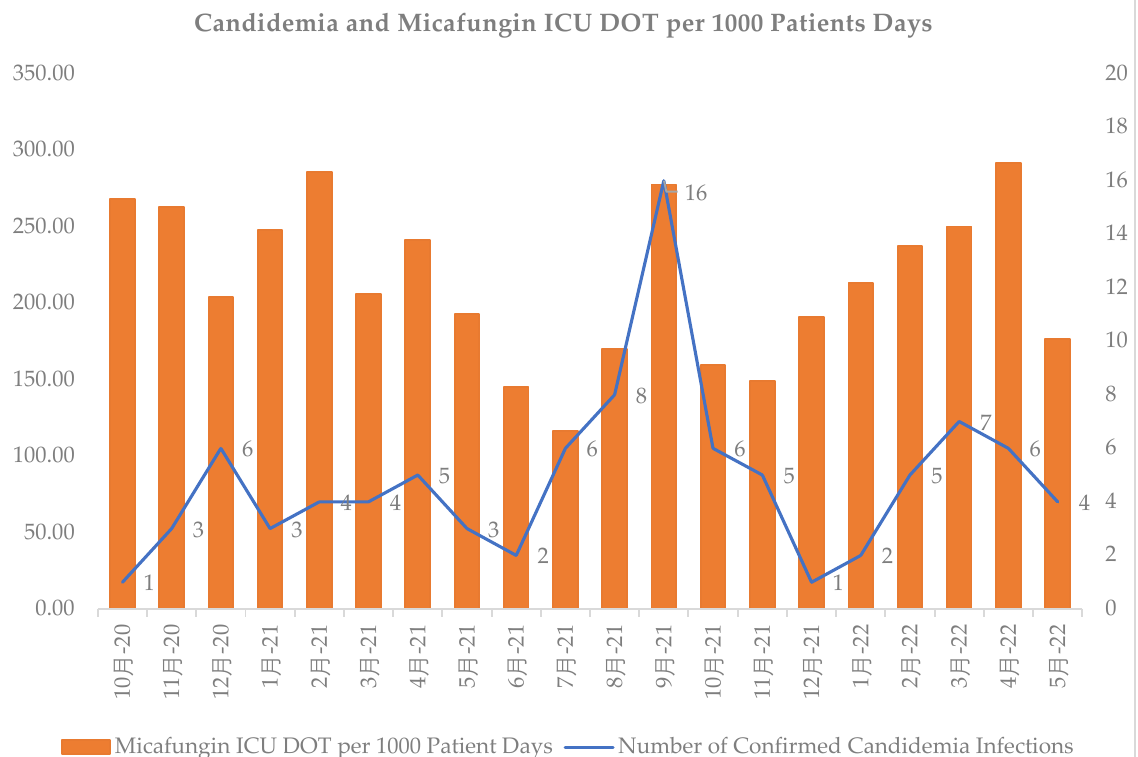
Figure 1. Number of confirmed cases of candidemia vs. days of micafungin therapy from October 2020 to May 2022 at an academic medical center. Chinese in figure is “month”.